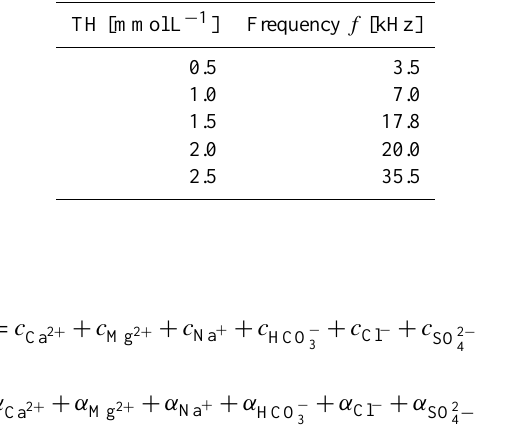
Figure 4. Qualitative plot of an impedance spectra.